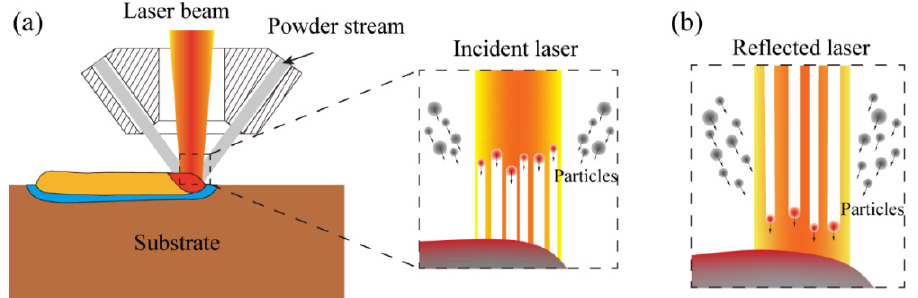
Figure 4. Schematic of the laser–material interaction: ( a ) the powder interacts with the incident laser; ( b ) the powder interacts with the reflected laser.